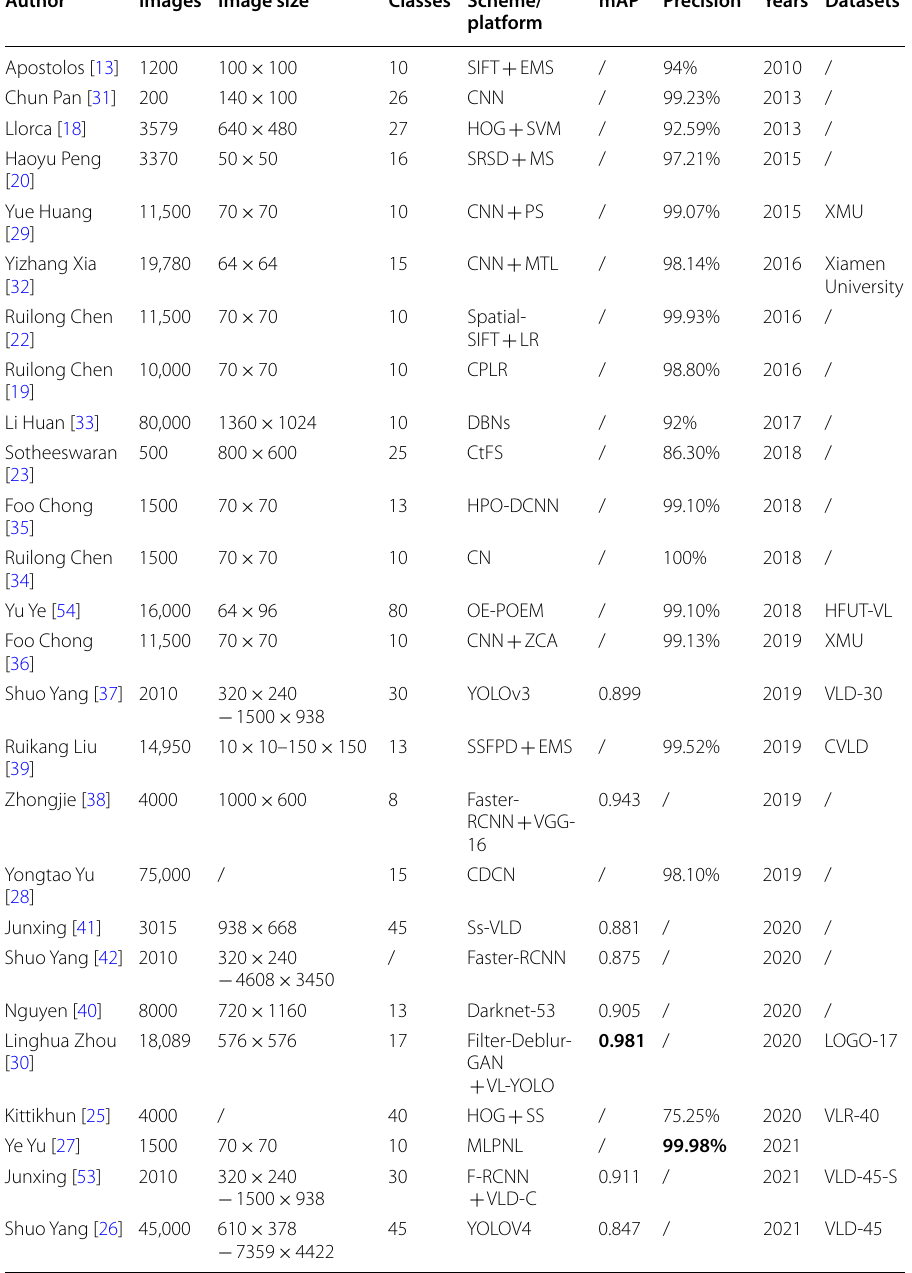
Table 1 The experimental results of some state-of-the-art handcrafted descriptor-based and deep- learning-based methods on different datasets from the year